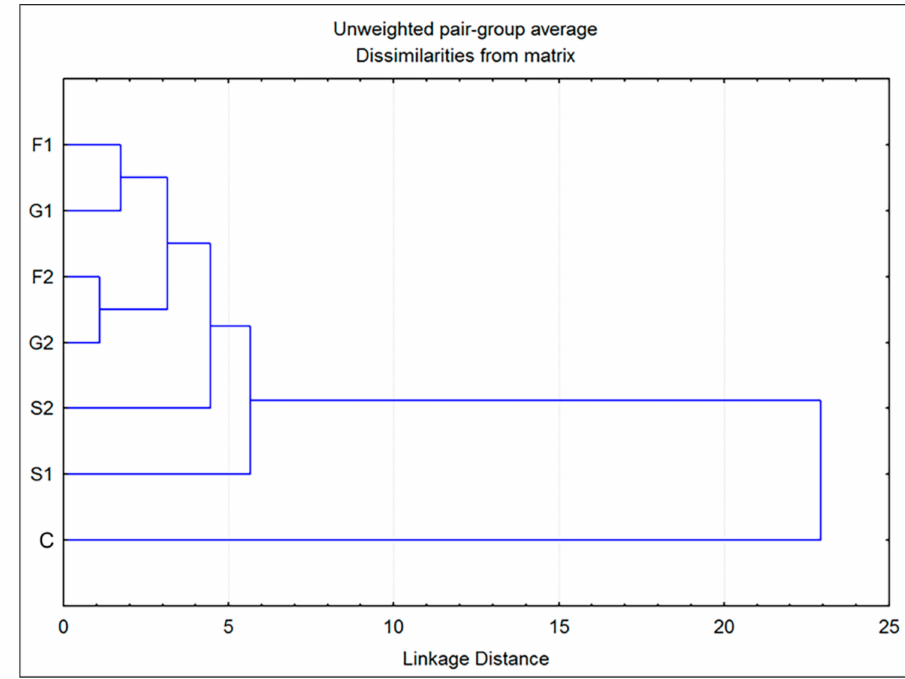
Figure 4. Dendrogram obtained by cluster analysis of 7 groups of Clinopodium pulegium plants based on 19 HS